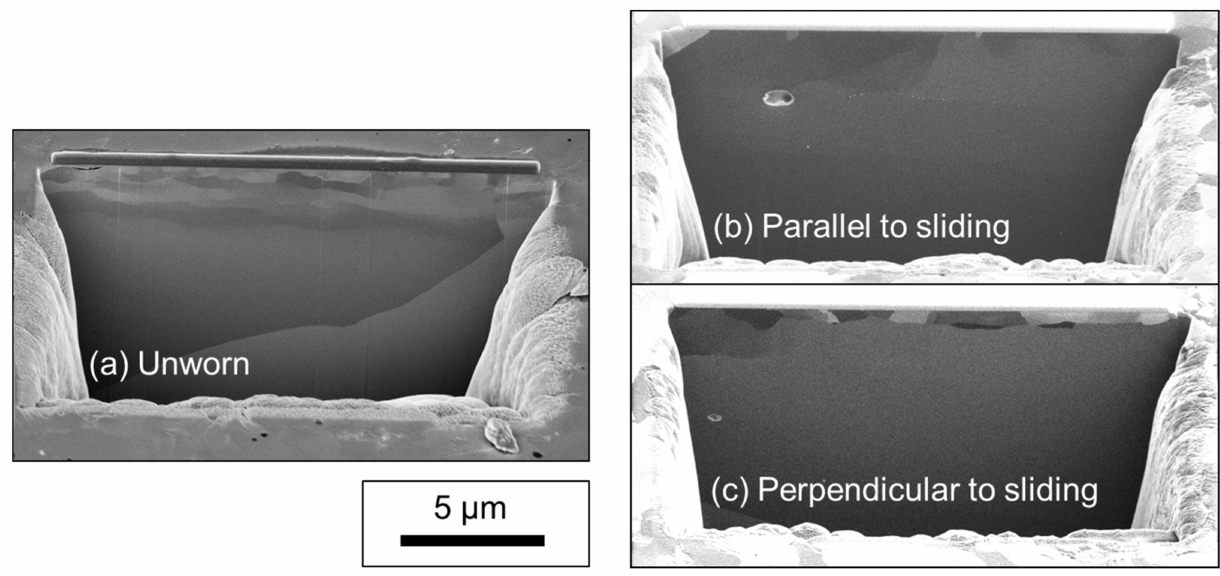
Figure 6. SEM/FIB cross-sectional image of ( a ) the unworn tungsten surface and ( b ) the worn tungsten surface in the parallel and ( c ) in the perpendicular direction generated using an on-line